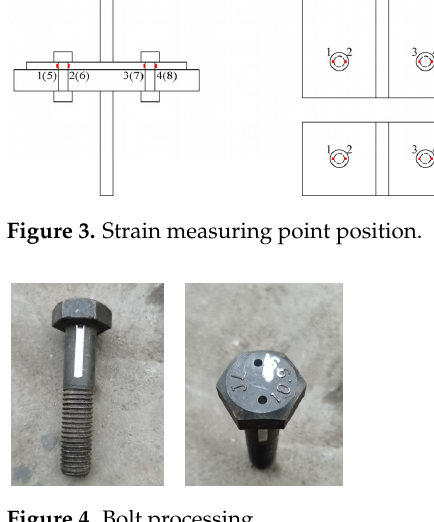
Figure 4. Bolt processing.